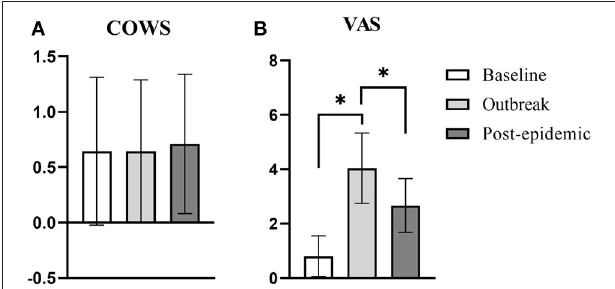
FIGURE 2 | Differences in the score of COWS and VAS in the three periods. (A) The difference in the score of COWS in the three periods. There is no difference in the score of COWS in the three periods. (B) The difference in the score of VAS in the three periods. When the outbreak, the score of VAS was significantly higher than the baseline and post-epidemic ( p < 0.01, p < 0.01, respectively). * p < 0.05.